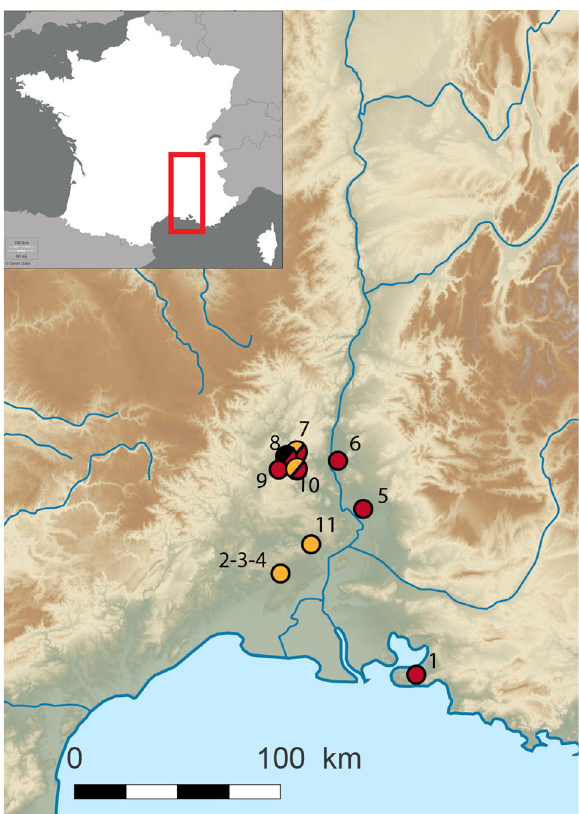
Figure 1: Distribution map of the sites of the corpus. In red, the sites attributed to the Cardial, in orange to the Epicardial. no. 1: La Font - des - Pigeons ( Cardial ) , no. 2: Le Mas de Vignoles X ( Epicardial ) , no. 3: Le Mas Neuf ( Epicardial ) , no. 4: la Roussillonne ( Epicardial ) , no. 5: le Baratin ( Cardial ) , no. 6: les Petites - Bâties ( Cardial ) , no. 7: Baume d ’ Oullins ( Cardial and Epicardial ) , no. 8: Baume de Ronze ( Cardial and indetermined Early Neolithic ) , no. 9: la grotte de l ’ Aigle ( Cardial ) , no. 10: Baume de Montclus ( Cardial and Épicardial ) , and no. 11: le Taï ( Epicardial )